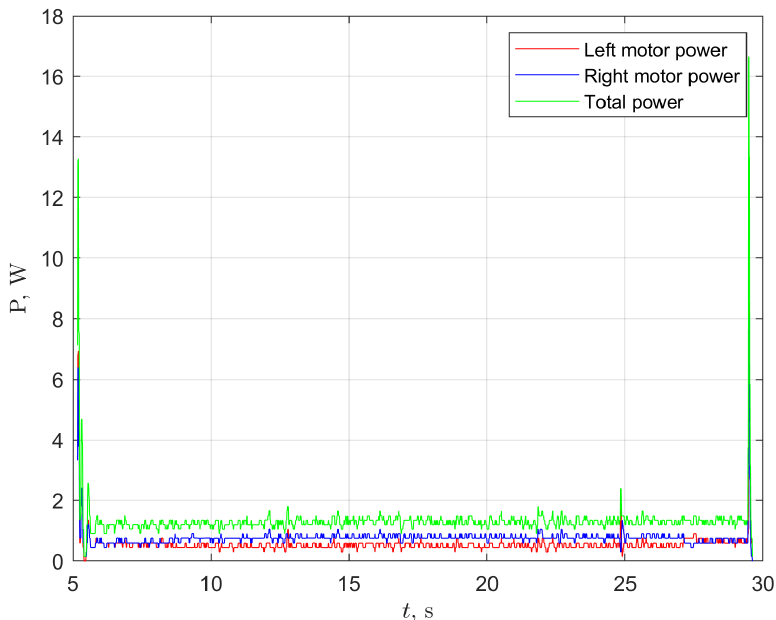
Figure 31. Individual motor power and the total power over time, for the highest value of the cost function equal to 1.3732—track